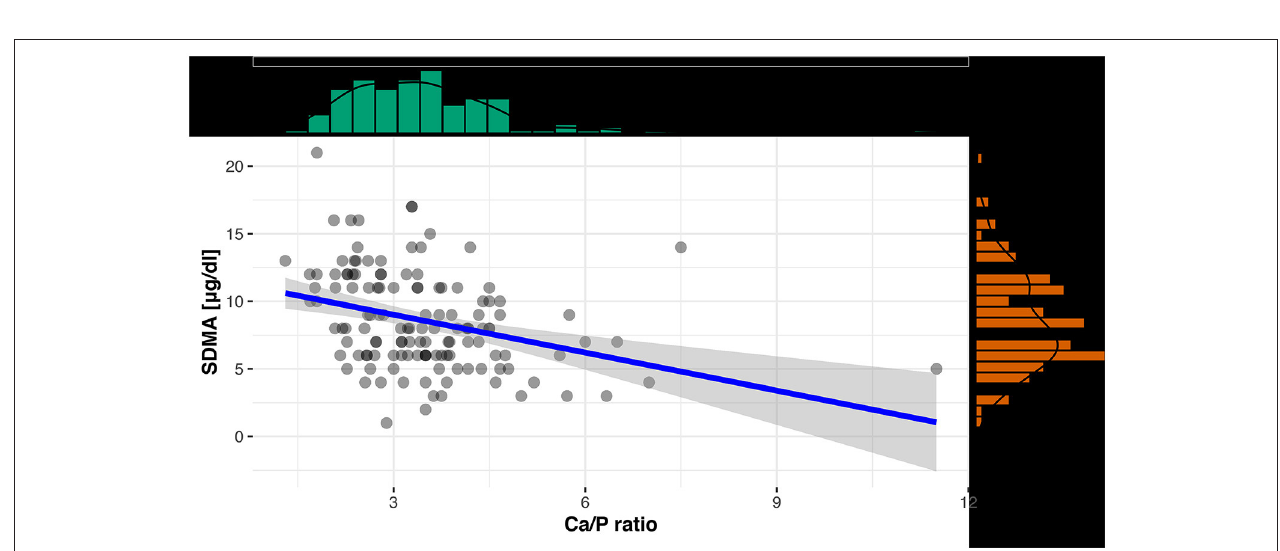
FIGURE 3 | Scatterplot with regression line and marginal distribution: correlation between SDMA and UA.